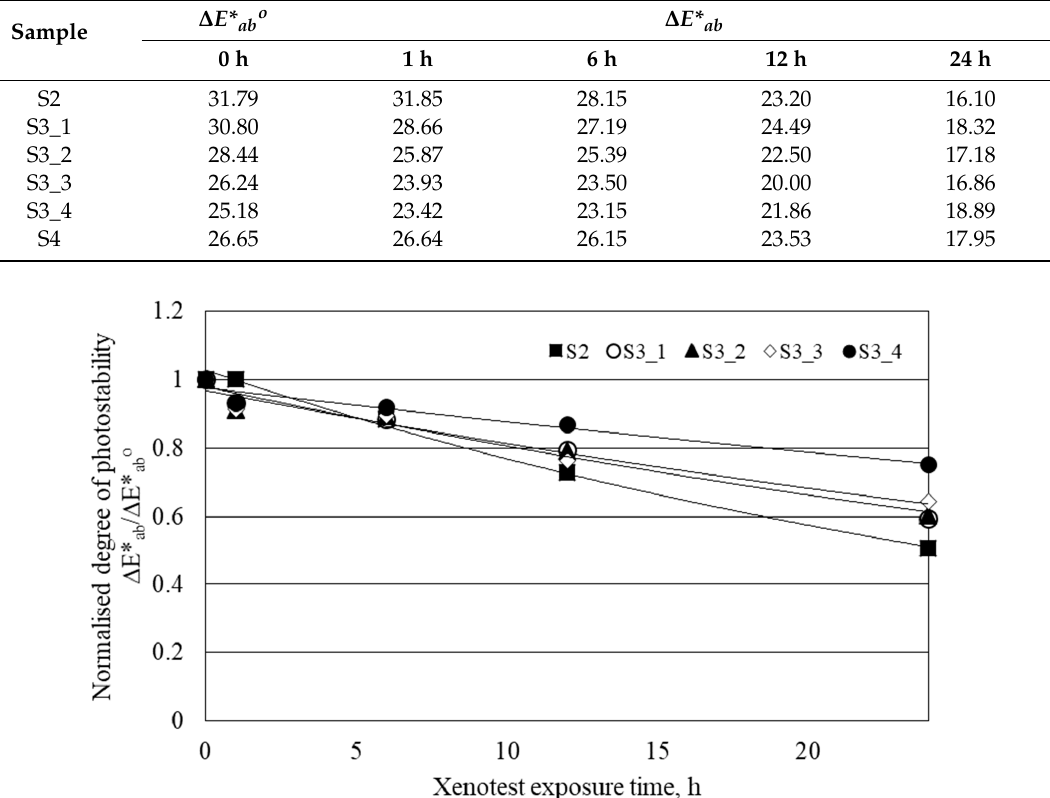
Figure 4. Normalized degree of photostability of studied samples.